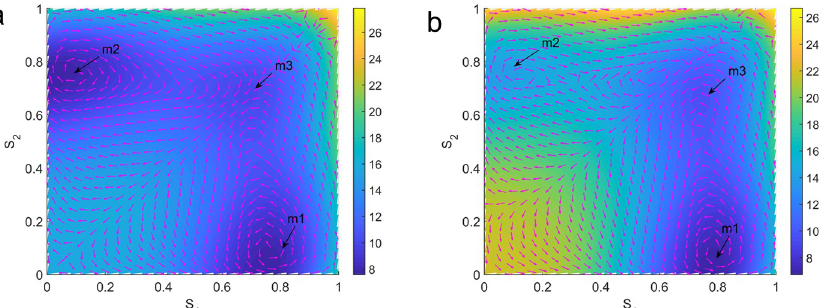
Fig 7. The non-equilibrium landscapes and flux in the absence and presence of a distractor stimulus. (a)There is no external stimulus presented. (b)A distractor stimulus is presented. The purple arrows indicate the flux part of driving force. m 1 and m 2 indicate the two memory attractors and m 3 indicates the new intermediate state. Here J + = 0.36 nA and J − = 0.05 nA . The color map indicates the value of potential ( U = − lnP ss ) at each state, which is a dimensionless quantity.